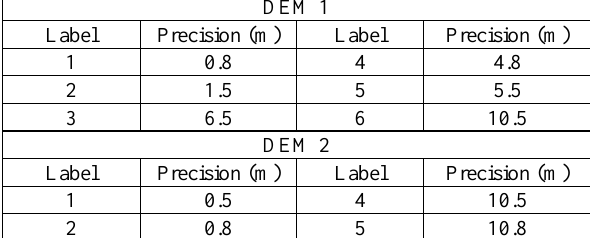
Figure 9. Final fusion